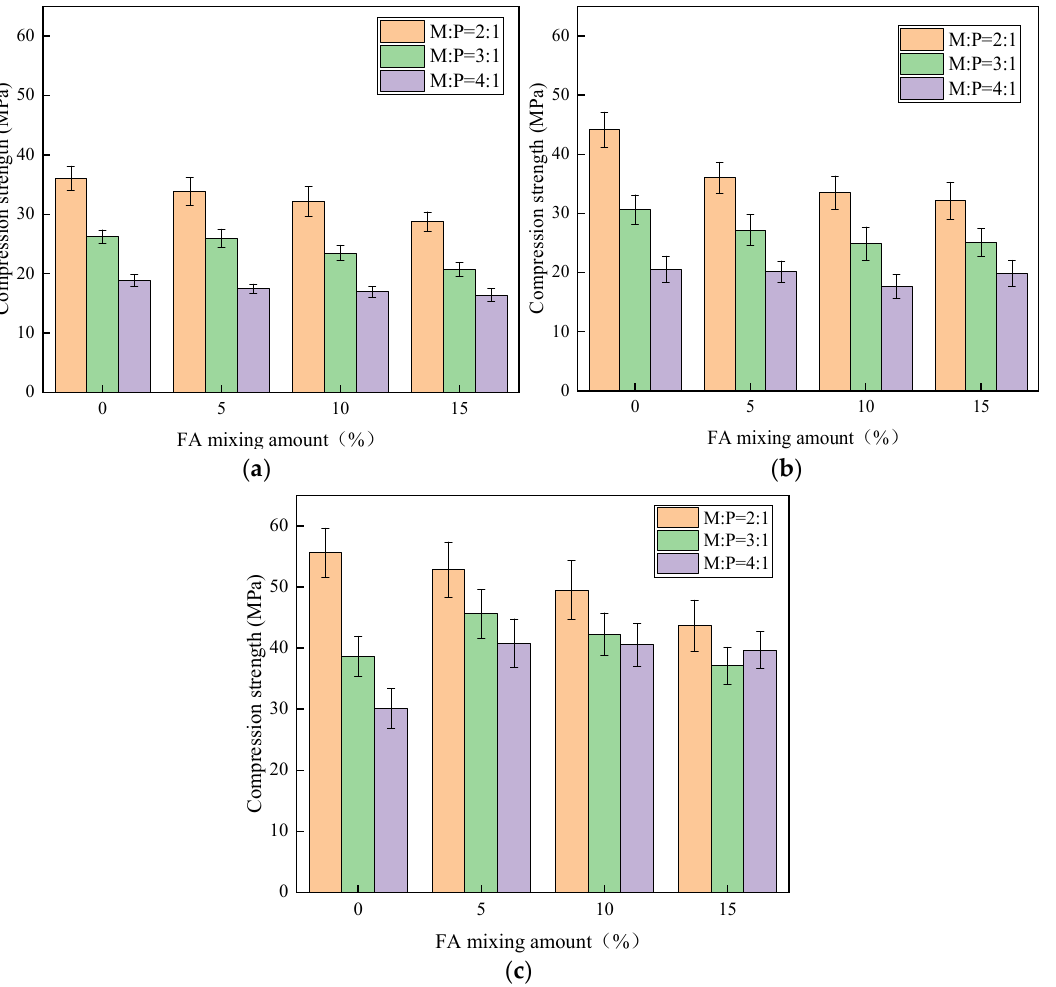
Figure 5. Compressive strength of potassium magnesium phosphate cement at different ages (unit: MPa): ( a ) Compressive strength of 1 d, ( b ) Compressive strength of 7 d, ( c ) Compressive strength of 28 d.